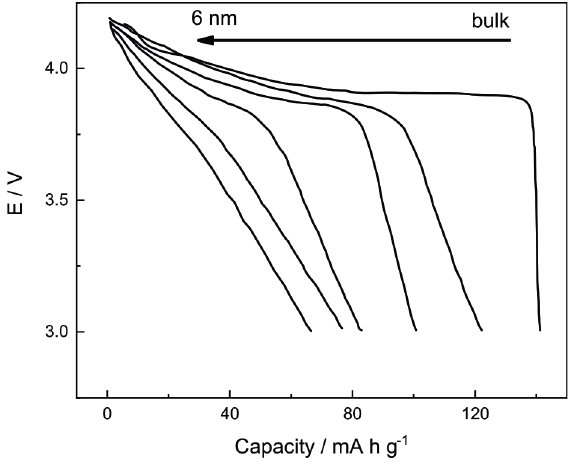
Figure 4. Particle size effect on the voltage profi le during galvanostatic reduction of LiCoO from (Okubo et al. 2007) with permission from the American Chemical